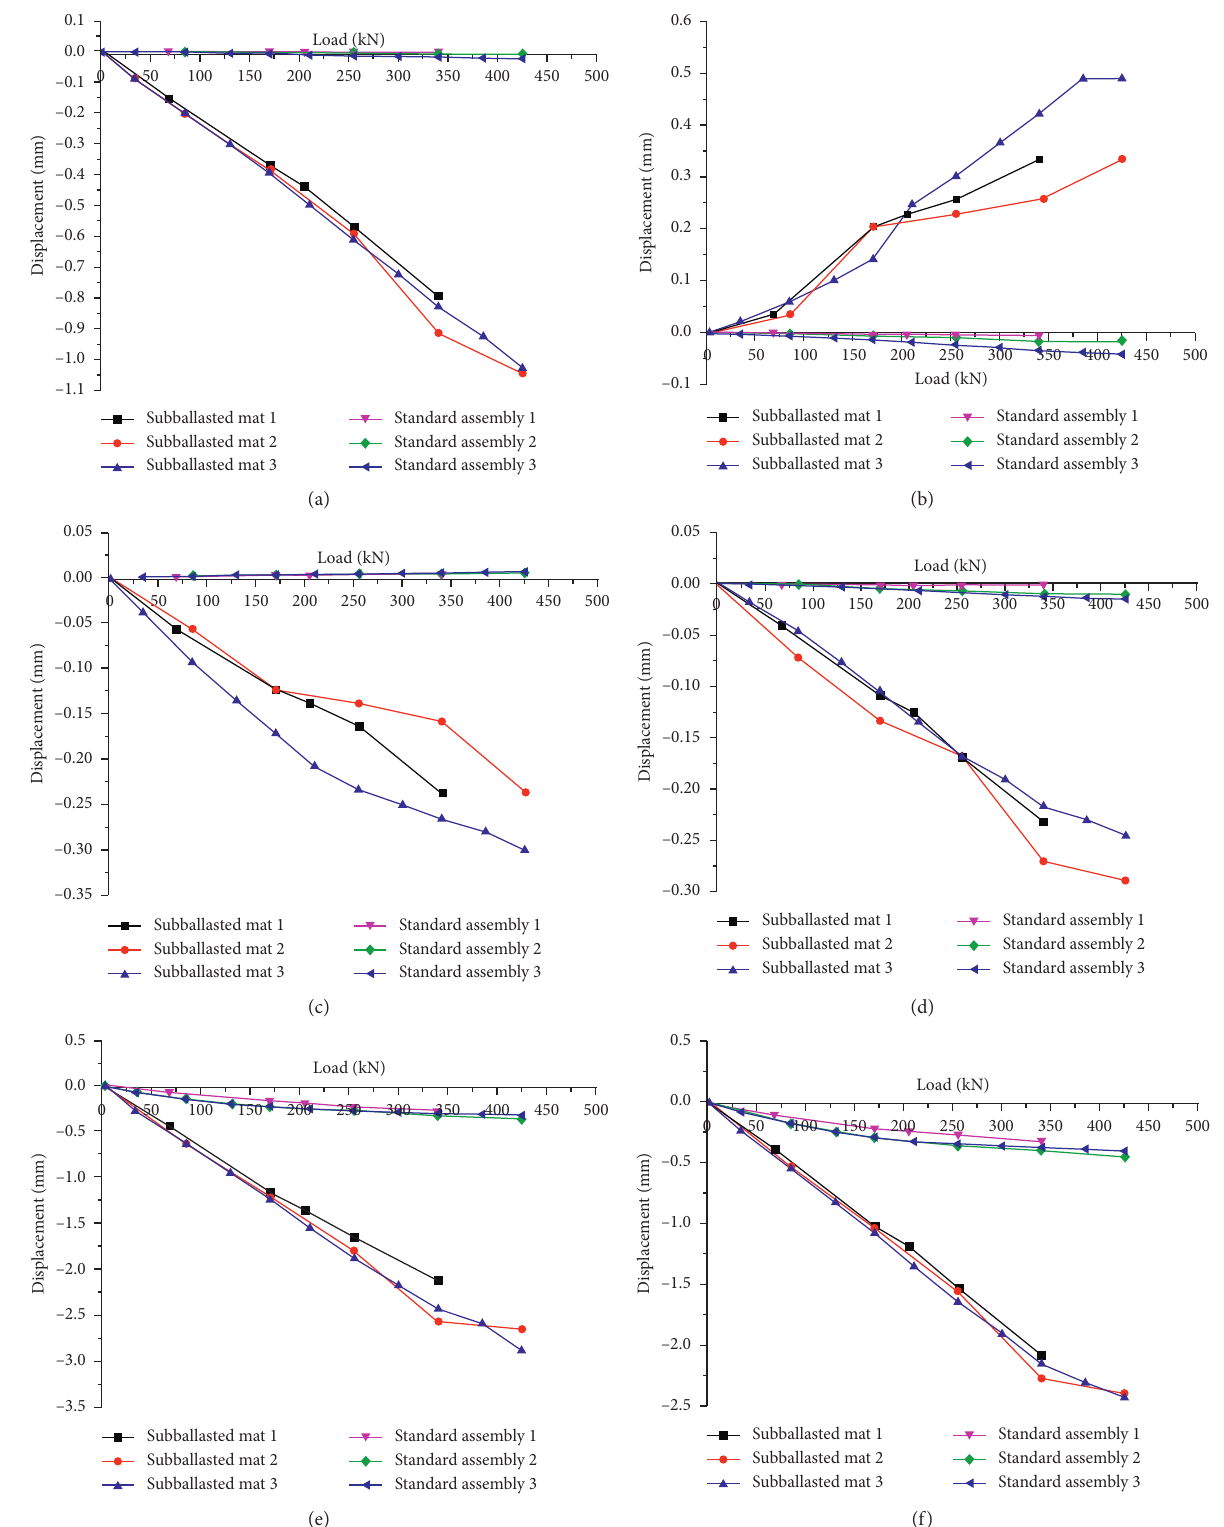
Figure 11: Interlayer deformations of the ballastless tracks loading at the slab end: (a) 1-1; (b) 1-2; (c) 2-1; (d) 2-2; (e) 3-1; (f)